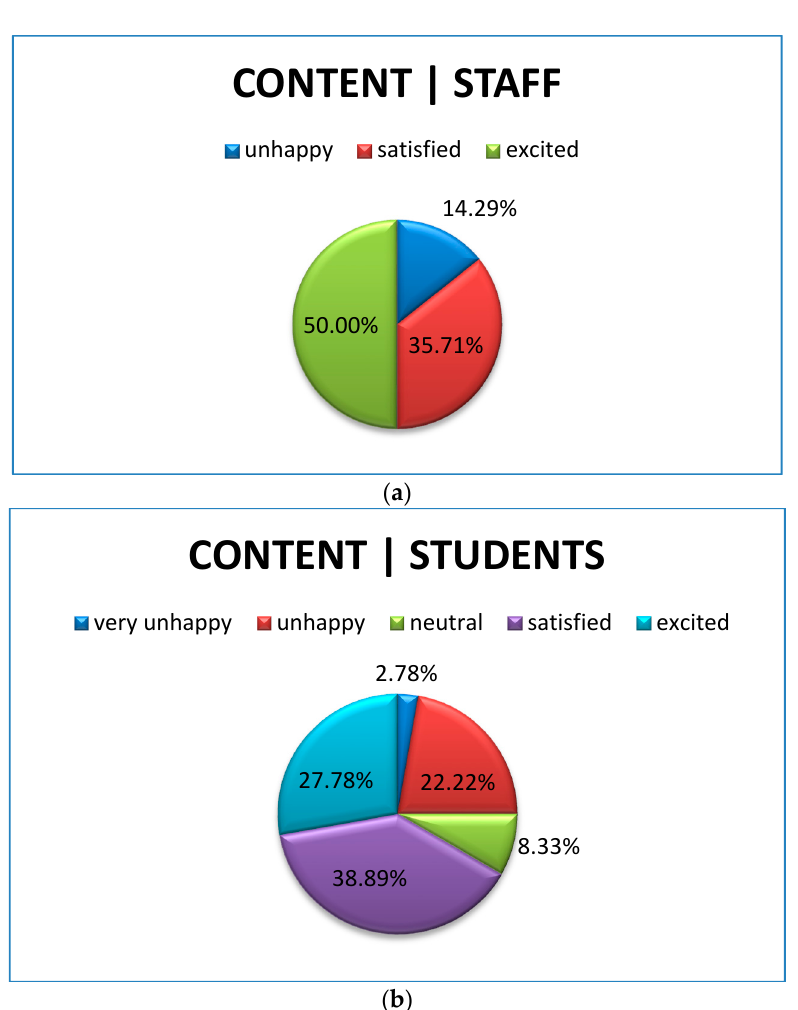
Figure 16. ( a ) Platform content evaluation results by school staff; ( b ) Platform content evaluation results by students.